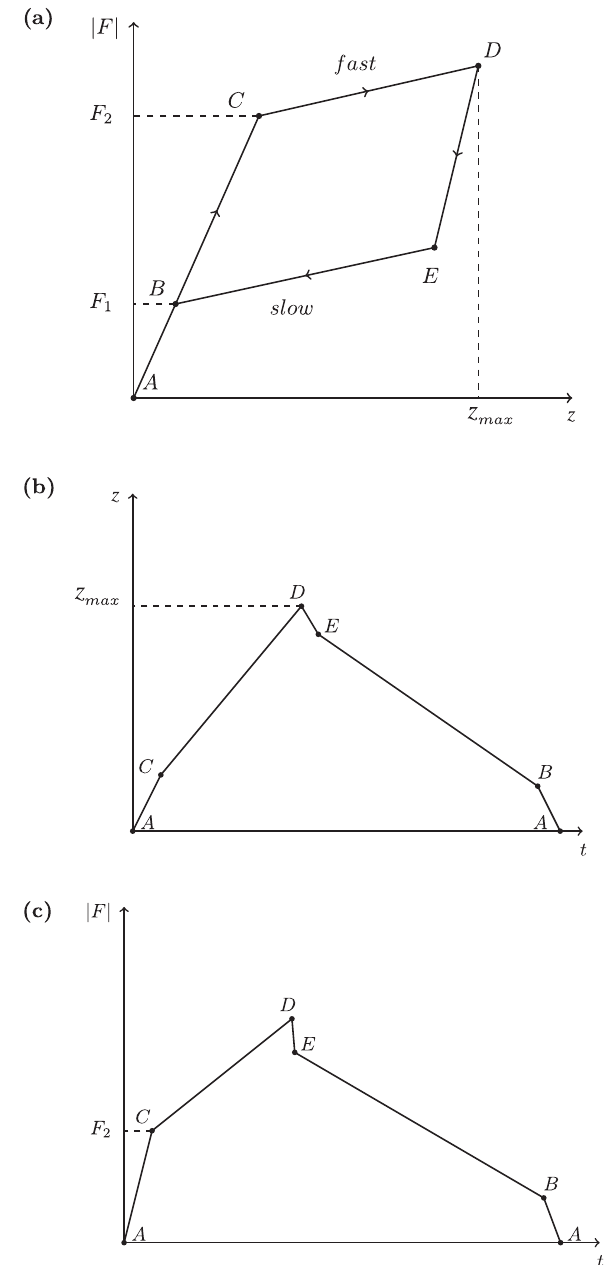
FIG. 3. Schematic diagrams illustrating the proposed nonequi- librium cycle of enzymes. j F j , z , and the trajectories z ð t Þ are ensemble-averaged quantities. (a) j F j is the ‘‘internal stress’’ of the enzyme, z the deformation. In this plane, a cycle opens if the forward conformational change is fast and the backward con- formational change is slow. In this picture, the substrate binds the (open) form of the enzyme A ; the process A ! B ! C ! D is driven by the forces between the substrate and the enzyme and is fast. D ! E corresponds to the chemical reaction and/or product release; the process E ! B ! A is driven by the internal restoring force of the enzyme (proportional to the free-energy gradient) and is slow. In (b) and (c), we sketch the corresponding time dependence of the deformation (‘‘reaction coordinate’’) z and the internal stress j F j